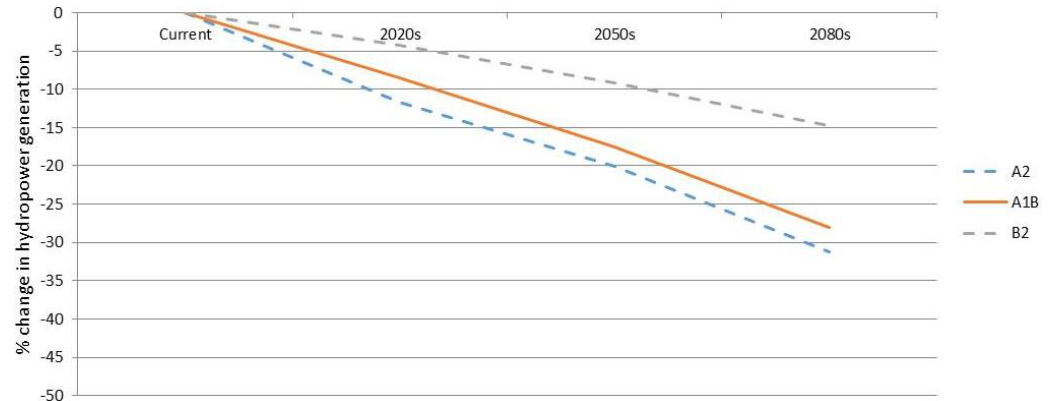
Figure 10. Change in generation capacity (%) for the Zambezi hydropower system for three different emission scenarios (A2, A1B and B2). Computed values for the 2020s, 2050s and 2080s compared to current climate (1961–1990).